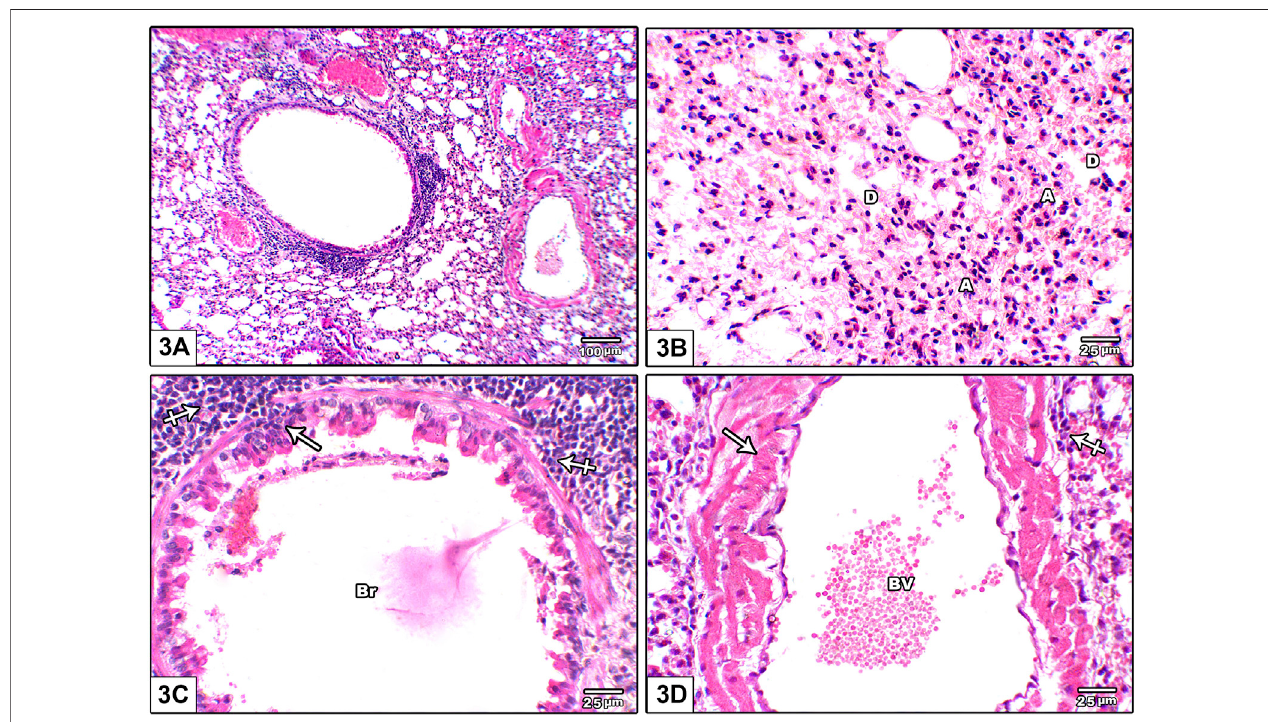
FIGURE 3 | Photomicrograph of H&E stained lung from le fl unomide 5 mg/kg group (A) An image shows disorganized lung architecture with mononuclear in fl ammatory cell in fi ltrate (B) An image shows areas of diffuse alveolar damage, pulmonary interstitium in fl ammatory cells in fi ltrate with interstitial alveolar hemorrhage. Most alveoli are collapsed (A) and few are dilated (D) (C) An image shows bronchiolar lumen (Br) with cellular debris (arrow) is seen with marked in fl ammatory cell aggregate around it (crossed arrow). Smooth muscle around it was thickened and heavily in fi ltrated with in fl ammatory cell (crossed arrow) (D) An image shows congested pulmonary blood vessels (BV) showing increased wall thickness (arrow) with foci of in fl ammatory in fi ltrate around it (crossed